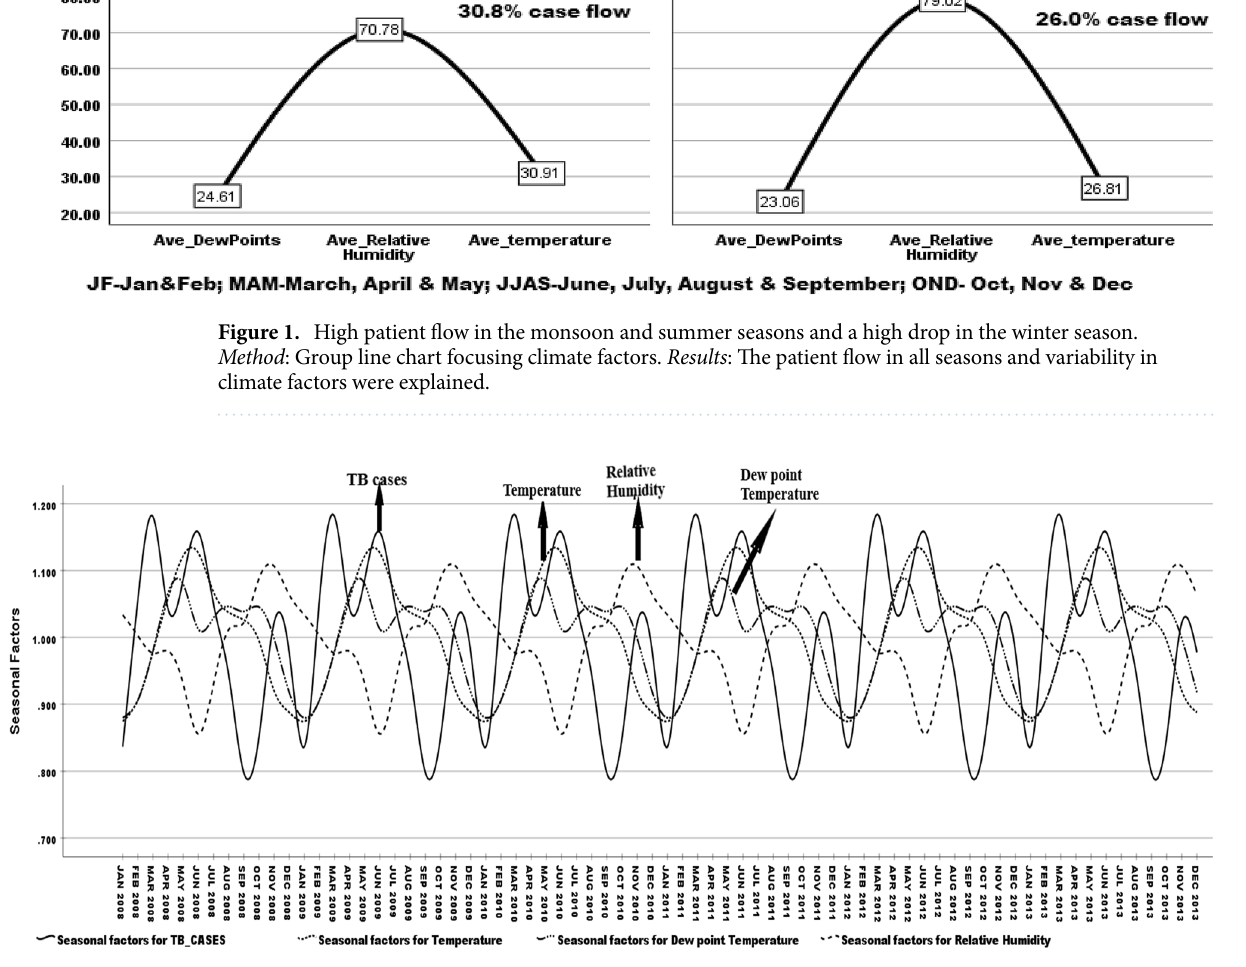
Figure 2. Climate factors influence TB infection in the seasons. Method : Individual line chart focusing on climate factors influencing TB infection. Results : Seasonal climate factors influence TB